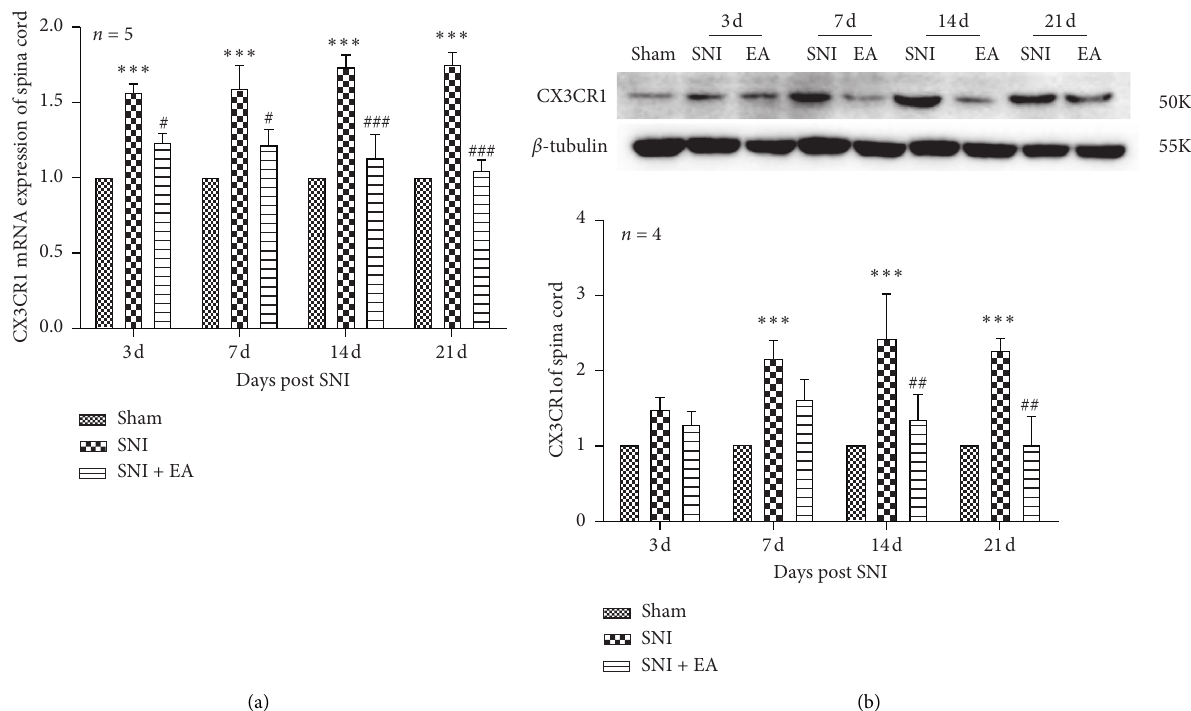
Figure 5: Effect of 2Hz EA on spinal CX3CRl expression in SNI rats. (a) Relative level of CX3CRl mRNA expression. (b) Western blotted band of CX3CRl and relative level of CX3CRl protein expression. Samples were collected from the L4-L6 segments of the spinal cord on days 3, 7, 14, and 21 postsurgery. ∗∗ P < 0 . 01, ∗∗∗ P < 0 . 001, compared to the sham group; # P < 0 . 05, ## P < 0 . 01, ### P < 0 . 001, compared to the SNI group. All data were expressed as the mean ± SEM, n � 4-5 per group. Two-way repeated-measures ANOVA followed by Bonferroni’s post hoc